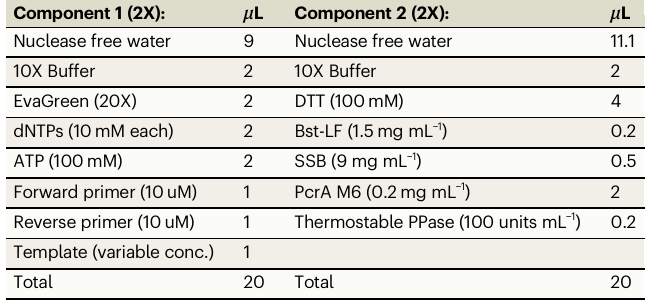
Table 1 | SHARP components for 40 μ L reaction